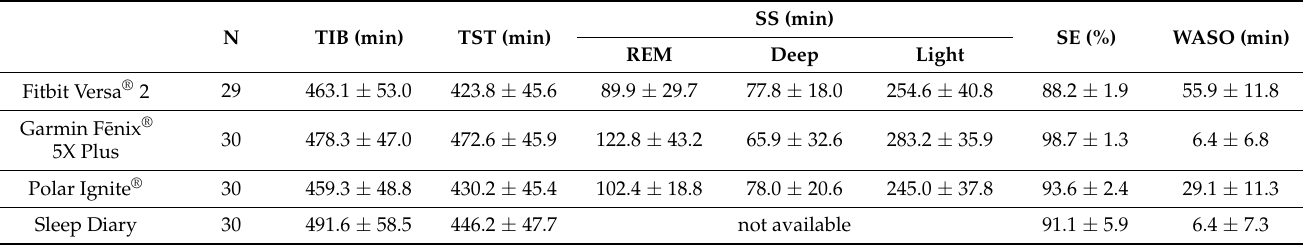
Table 2. Mean values of sleep